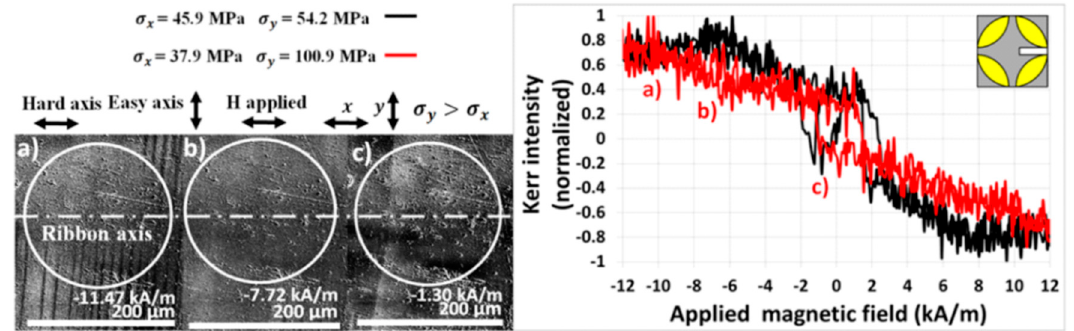
Figure 12. Magnetic domain patterns and magnetization curves (pressure force 6.867 N) of the sample (10 × 8) mm 2 under applied tensile stress sensitive to the longitudinal M x magnetization component.